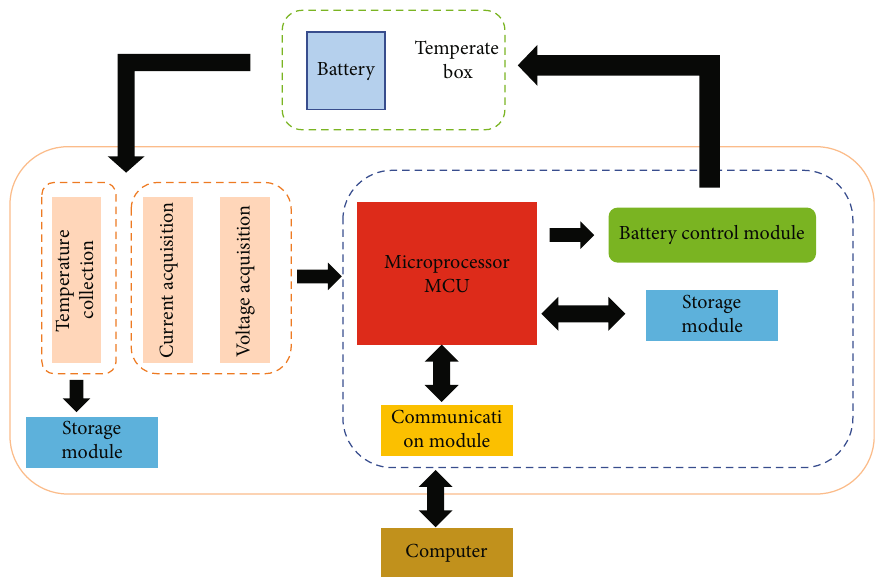
Figure 4: Test framework and schematic